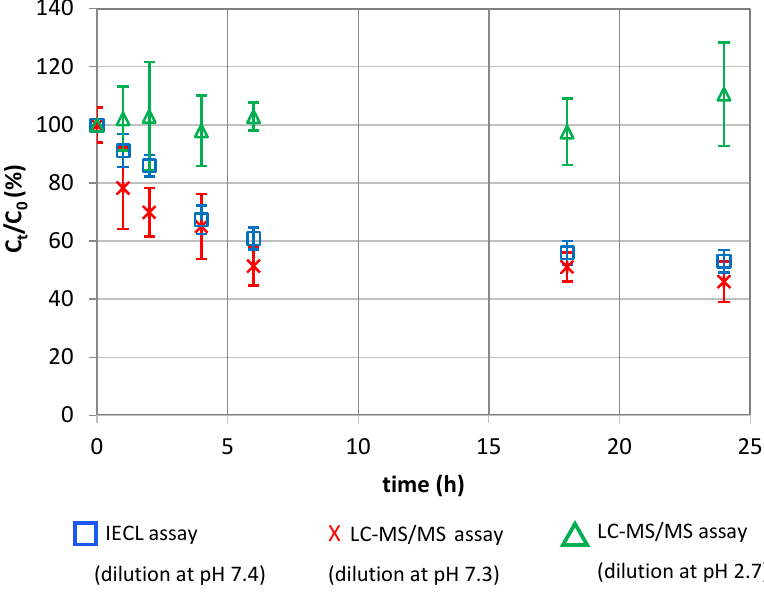
Figure 4. Stability of R-insulin (0.7 mg/L Umuline Rapide ® at t 0 ) at 25 ◦ C in a binary PN admixture (medium 1), containing 17.5% dextrose at pH 6.3; blue squares, data from the IECL assay after dilution in a pH 7.4 solution; red crosses, data from the LC-MS/MS assay after dilution in a pH 7.3 solution; green triangles, data from the LC-MS/MS assay after dilution in a pH 2.7 solution. After dilution of the samples in non-acidic media, the chromatogram recorded for the glycated R-insulin transition (995.8 → 995.8) always featured the peak characteristic